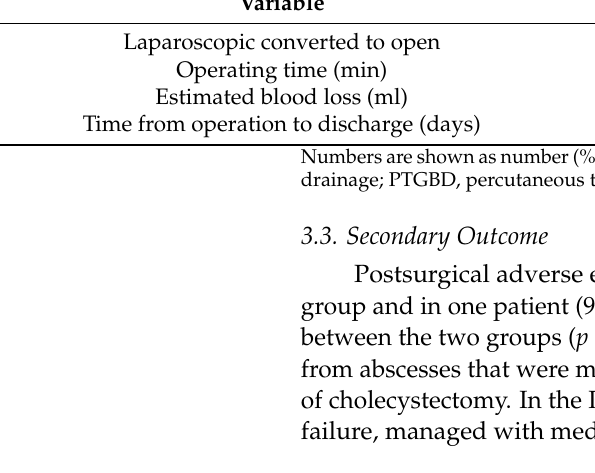
Table 3. Comparison of adverse